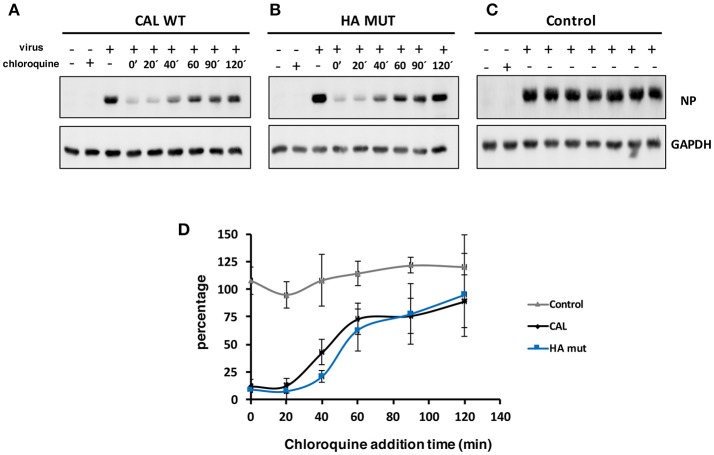
CAL and HA entry in A549 cells. A549 cells were infected with 3 pfu/cell with (A) CAL, (B) HA mut, or (C) CAL control viruses and left untreated (–) or treated with 75 μM chloroquine (+) that was added at the indicated times of the infection and was left for 2 h after each indicated time of chloroquine addition. Then, chloroquine was removed and the infection continued until 8 hpi. Infected cells were harvest at 8 hpi and used for NP and GAPDH detection by Western blot. A representative image of each condition is shown. (D) Ratios of NP/GAPDH accumulation in treated cells compared with untreated cells in parts A and B, or compared with 0 hpi in part (C) of three independent experiments using different viral stocks are shown. NP/GAPDH ratio obtained in cells untreated and infected was taken as 100%. The experiment was performed in triplicates with two different viral stocks. Significance was determined by two-way ANOVA with Bonferroni post-hoc test, (ns) not significant.